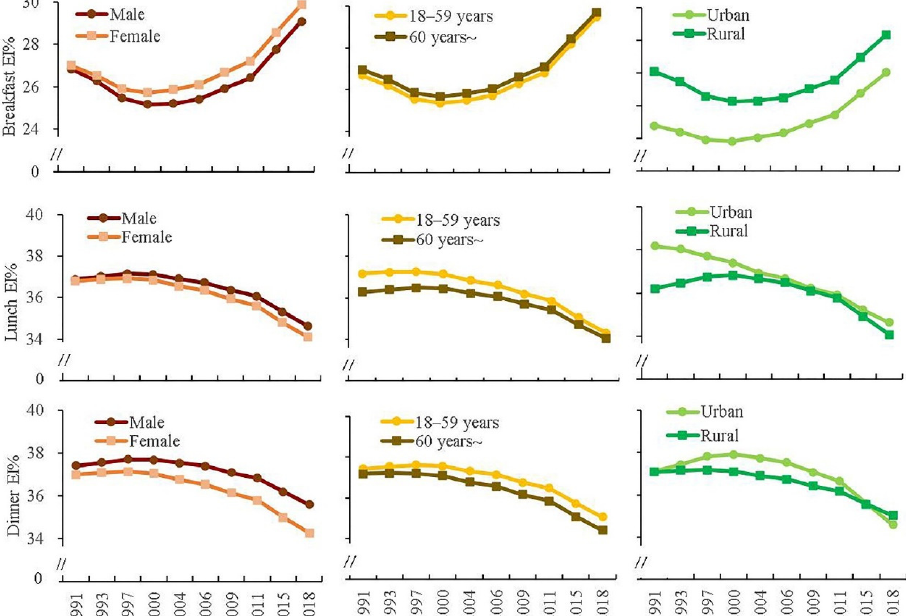
Figure 2. Marginal means of energy proportion of breakfast, lunch, dinner by gender, age-group and location 1 . 1 Marginal mean was calculated from multilevel linear mixed model. Models were adjusted for age, gender, educational level, geographical region, total physical activity, smoking, alcohol drinking, annual per capita household income, community urbanicity index, chronic disease history, total energy intake, and BMI.